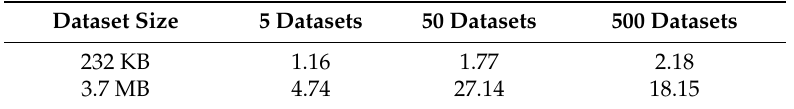
Table 2. Extraction time per dataset, in seconds, when the platform contains multiple registered